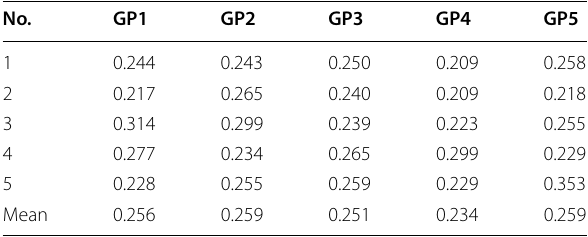
G3 ( L. Acidophillus , G4 L. casei , G5 L. lactis , Gl (positive control, L . Plantarum ), G2 (control, no bacteria)